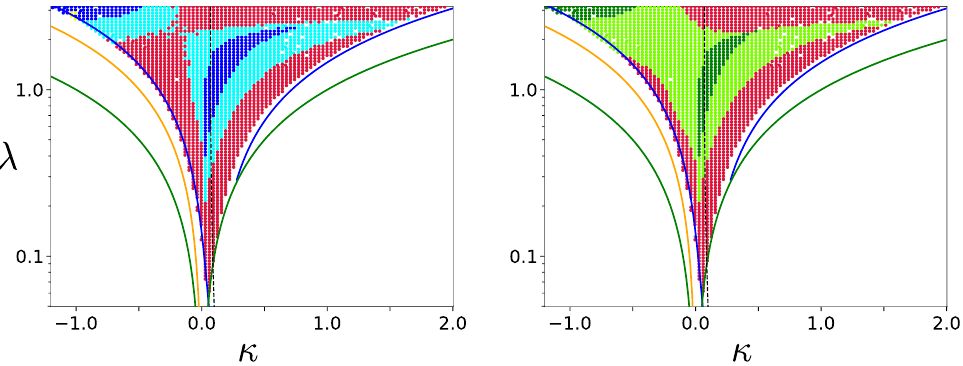
Figure 4. The same as in figure 2 but for the case of Z 2 breaking by one twin Yukawa coupling ˆ y τ = 1 . 34 corresponding to the maximal strength of the phase transition for the benchmark point with λ = 1 , ρ = 0 and f 0 = 4 v A , as demonstrated in figure